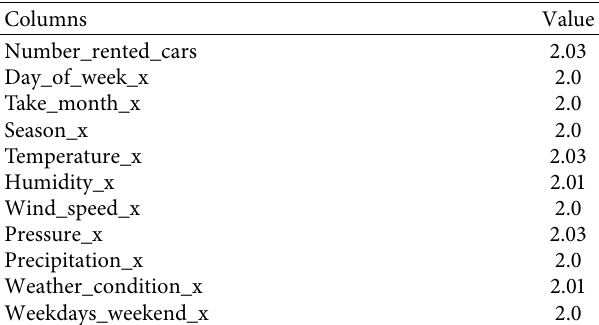
Table 5: Check for serial correlation of